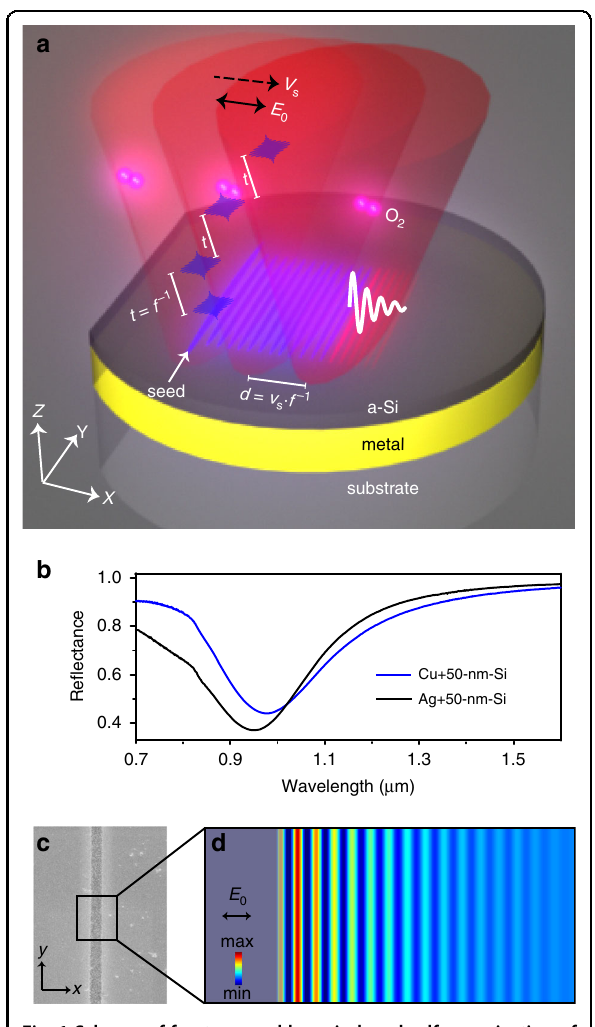
Fig. 1 Scheme of femtosecond laser-induced self-organization of nanogratings on silicon-on-metal thin fi lms. a A line-focused laser is employed to manufacture wafer-scale nanogratings on thin- fi lm ffiffiffiffiffiffiffiffiffiffiffiffiffiffiffiffiffiffiffiffiffiffiffiffiffiffiffiffi absorbers, consisting of an amorphous Si coating on a low-loss metal fi lm such as silver or copper. When scanning the samples along ω 2 ε m ; Si ; air c 2 x -direction (dashed arrow), parallel nanostripes are replicated from a seed. f : laser repetition rate; t = f − 1 : time interval between adjacent pulses; v s : scanning speed; d = v s f − 1 : spatial distance between adjacent pulses. E 0 : laser polarization direction. O 2 : oxygen, which plays an important role in the grating formation. b Normal incidence re fl ection spectra of 100-nm-thick Cu and Ag coated with 50 nm of Si. c SEM image of a single pulse-induced ablative slit on Si fi lm. Its width is measured to be <2 µm. d Numerical illustration the formation of standing wave at air-Si interface via laser-SPP interference. In simulation, we set a 2-µm-width slit indentation (dark area) as seed in the Si fi lm to excite the